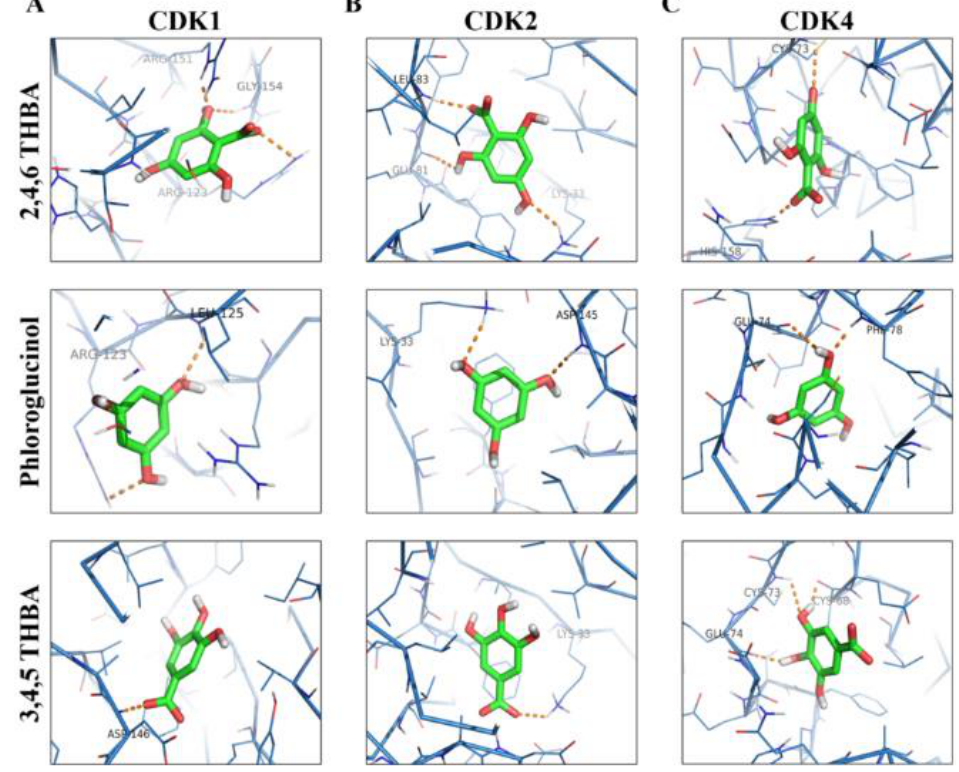
Figure 5. Molecular docking studies showing the potential interactions of 2,4,6-THBA (upper panel), phloroglucinol (middle panel) and 3,4,5-THBA (lower panel) with CDK1 ( A ), CDK2 ( B ) and CDK4 ( C ).